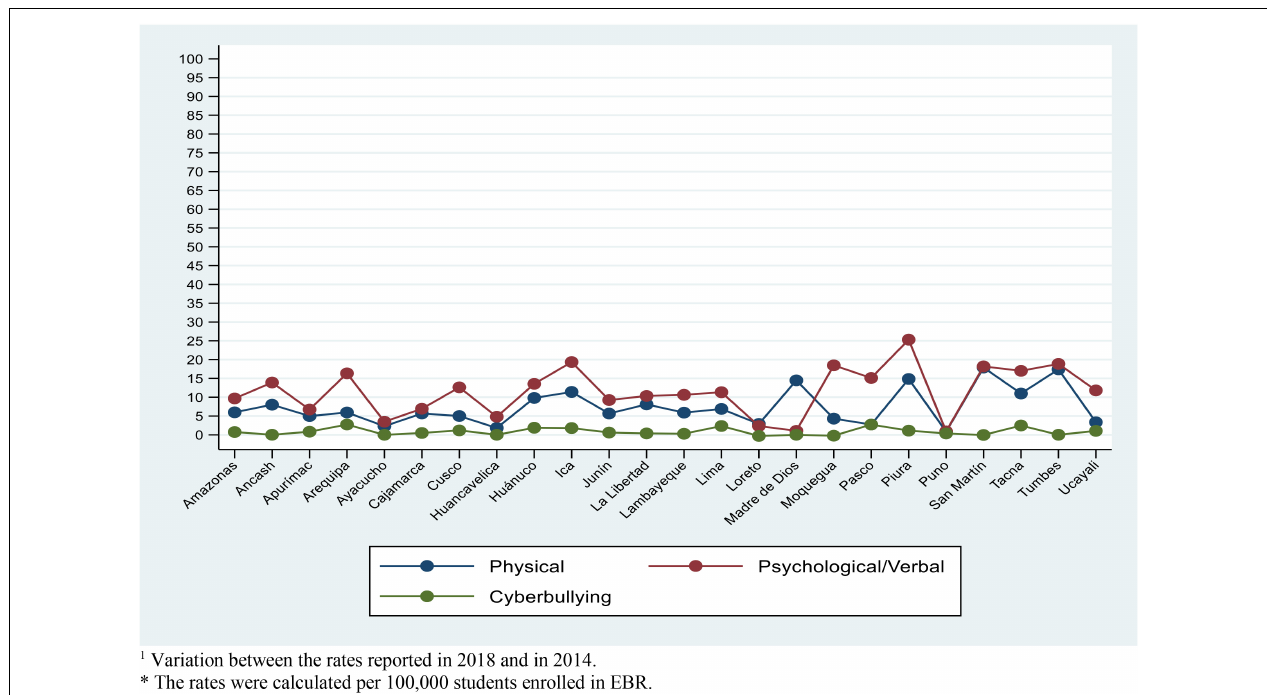
FIGURE 2 | Change in rates reported by bullying type in 2018 compared to 2014, according to departments in Peru. Variation between the rates reported in 2018 and in 2014. The rates were calculated per 100,000 students enrolled in EBR.